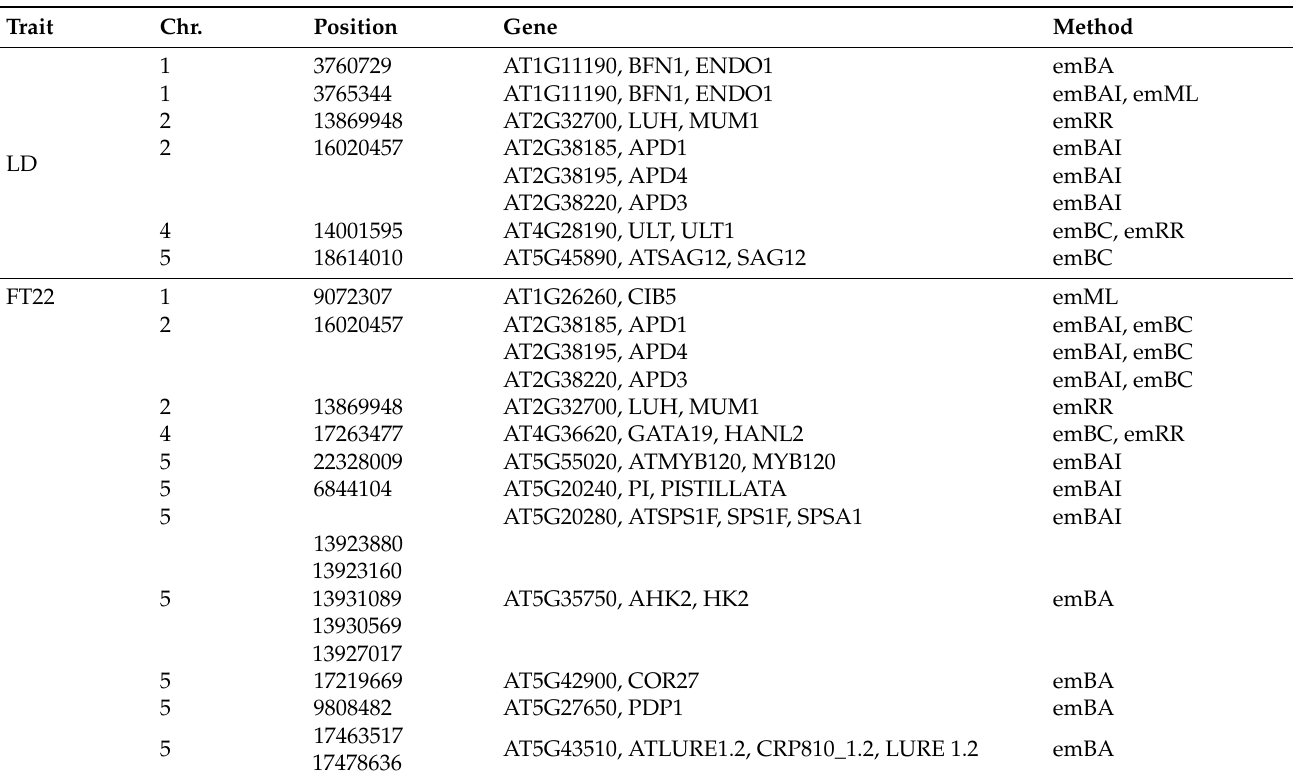
Table 1. The confirmed genes (top 20) using five methods, including emBAI, emBA, emRR, emML and emBC for LD and FT22 in Arabidopsis natural